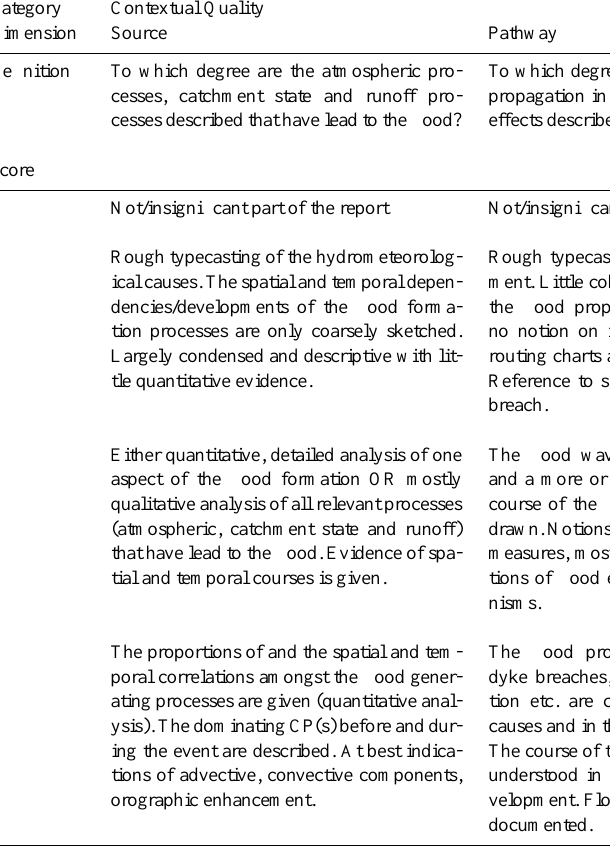
Table A2. Definitions of the quality dimensions and their respective scores for the “Contextual Quality” quality